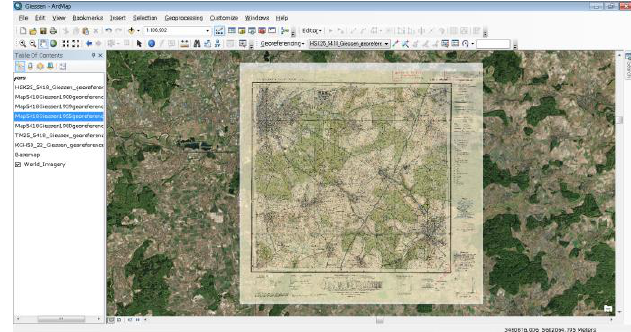
Figure 8. Old topographic map, Giessen pronunciation